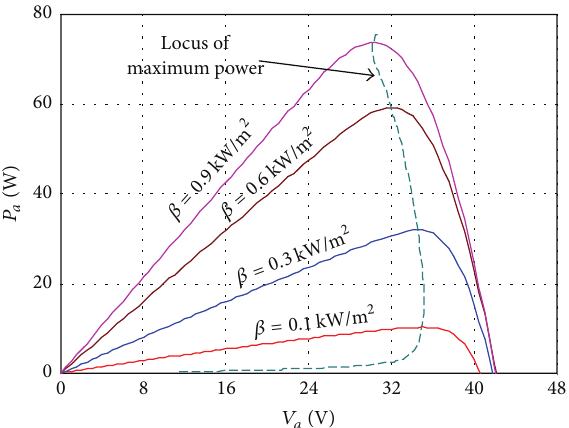
Figure 8: 𝑃 - 𝑉 curves of array when 𝛼 is fixed at 0.8 kW/m 2 . The locus of maximum power passes through the peak of each 𝑃 - 𝑉 curve.